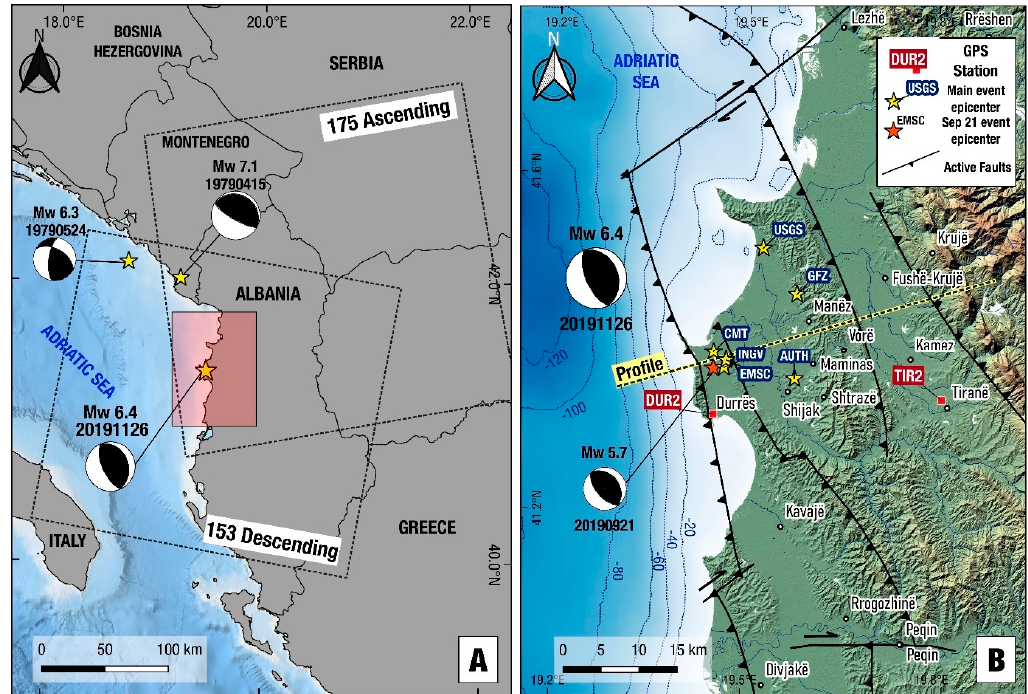
Figure 1. ( A ) Map of the south Adriatic Sea—Albania showing extent of Sentinel-1 satellite frames. Adriatic Sea bathymetry data from https://www.emodnet-bathymetry.eu/. Beachballs indicate the focal mechanisms of recent strong, shallow earthquakes [14]; USGS, Table 2; compressional quadrants are shaded in black). Shaded rectangle indicates study area shown in 1b. ( B ) Relief map of the Durres–Tirana area in central-western Albania showing main geological structures (thrust faults; ticks on the upthrown side), epicentre (yellow stars) determined by various agencies and Global Navigation Satellite System (GNSS) stations that recorded the earthquake. Beachball indicates the United States Geological Survey (USGS) focal mechanism of the Nov. 26, 2019 earthquake. Red star indicates the European Mediterranean Seismological Centre (EMSC) epicentre of the September 21, 2019 M w = 5.7 earthquake (Focal mechanism from USGS). Fault lines are from [22]. Yellow line indicates the profile in Figure 6. Table 1. Determination of the parametric data of the Nov. 26, 2019 02:54 UTC earthquake by various Table 2. Focal mechanism data for the 26 November 2019 M w = 6.4 earthquake. agencies. Institute